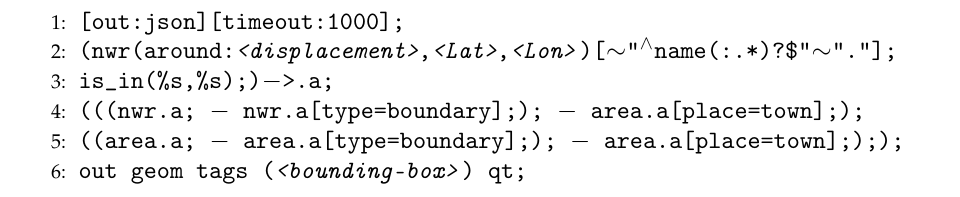
Figure 3. Code snippet of an Overpass